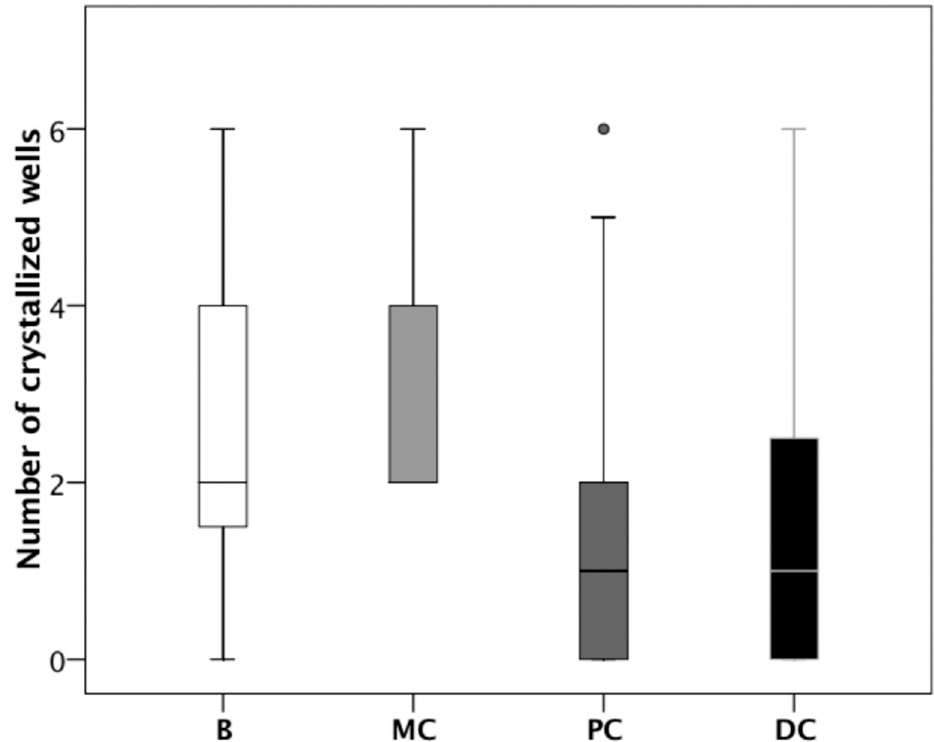
Figure 4. UAC test results at baseline (B) and after consumption of milk chocolate (MC), chocolate powder (PC), and dark chocolate (DC). Samples were compared using the Wilcoxon signed-rank test. Boxplots show the median (inner horizontal line), interquartile range (box), 95% confidence interval (vertical lines), and outlier (circle).